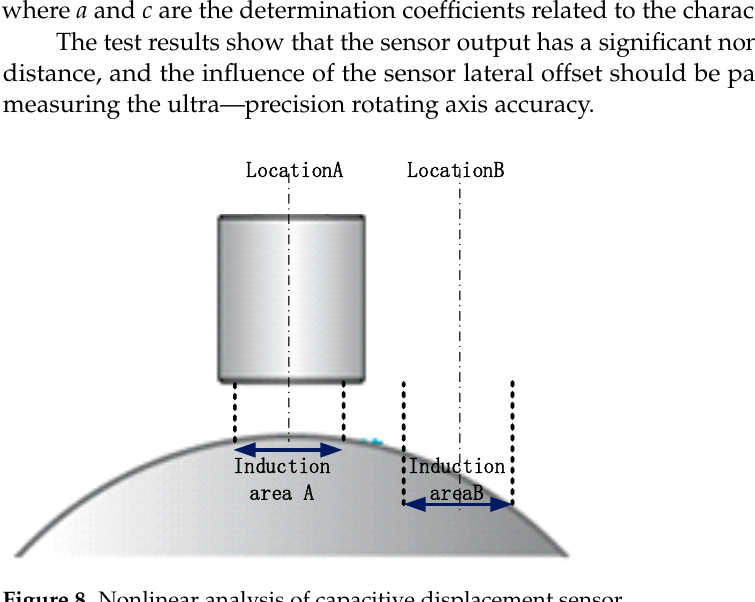
Figure 8. Nonlinear analysis of capacitive displacement sensor.